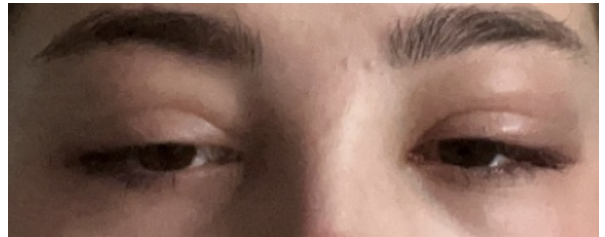
Figure 3. Oedema during the fifth